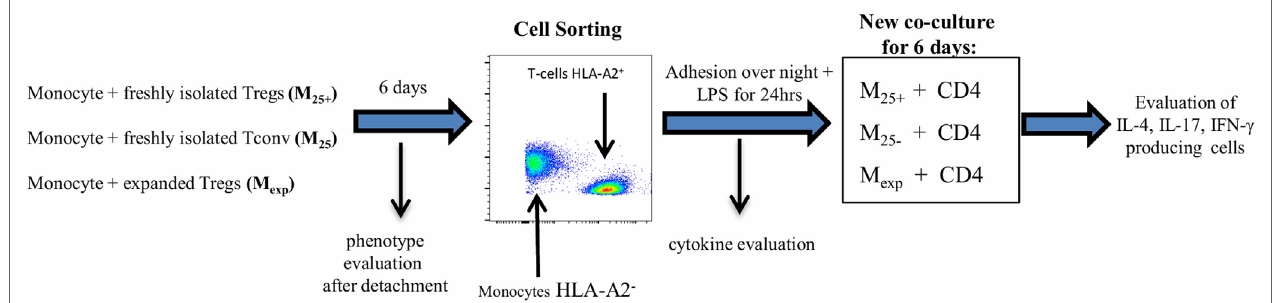
FigUre 1 | Experimental protocol. Co-culture experiments have been settled in 48-well plates pre-coated with anti-CD3 monoclonal antibody (50 ng/mL). 0.5 × 10 6 monocytes (HLA-A2 − ) have been cultured in the presence of 0.25 × 10 6 T cells (HLA-A2 + ) for 6 days. The resultant monocyte populations have been identified as M 25 + [monocytes co-cultured with freshly isolated CD4 + CD25 + regulatory T cells (Tregs)], M 25 − [monocytes co-cultured with freshly isolated CD4 + CD25 − conventional T cell (Tconv)], and M exp (monocytes co-cultured with expanded Tregs). Cells were then detached and labeled with Live/Dead dying and HLA-A2 antibody for cell sorting following the gate strategy reported in Figure S1 in Supplementary Material. At the same time, the expression of CD86, CD14, CD80 CD40, CD206, CD163, and HLA-DR has been evaluated by flow cytometry. After sorting, 150 × 10 5 cells have been lysed for WB analysis and 50 × 10 3 cells per condition were placed in a new 48-well plate and left at 37°C overnight to ensure complete adhesion. Adhering cells have been stimulated with LPS for 24 h and then co-cultured, for other 6 days, with allogeneic CD4 T cells (10 5 per condition, HLA-A2 + coming from the same donor of the Tconv/Treg) in presence of soluble anti-CD3 (50